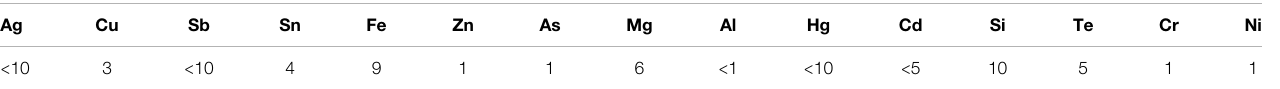
TABLE 1 | Content and composition of the impurities in the lead bismuth alloy as-received. All elemental concentrations are given in ppm Wt. %; the balance is LBE.